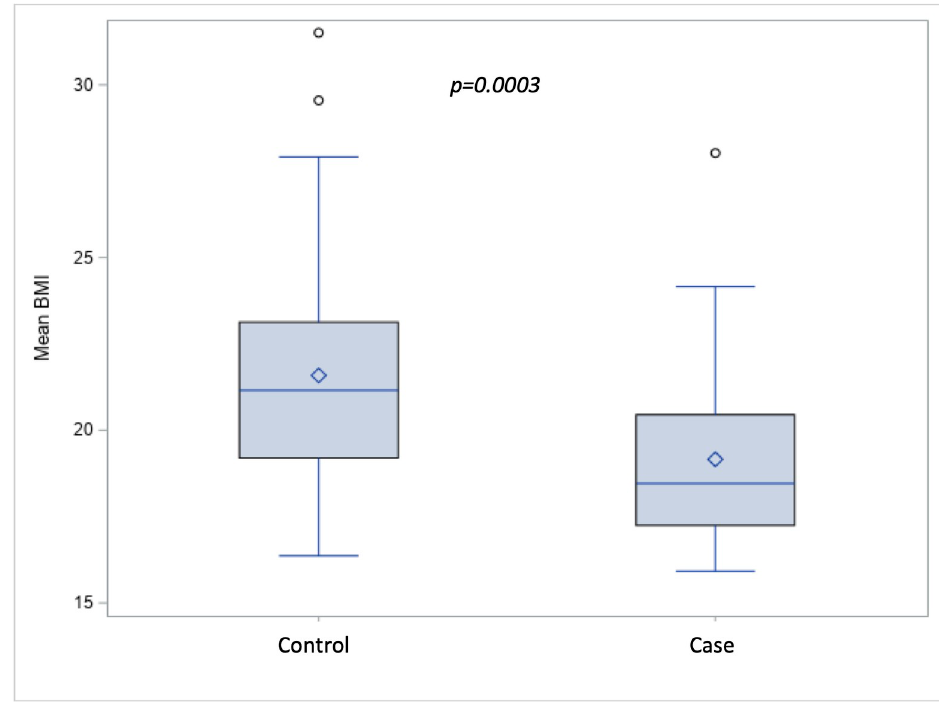
Fig 1. Comparison of mean BMI (kg / m 2 ) between cases and control.